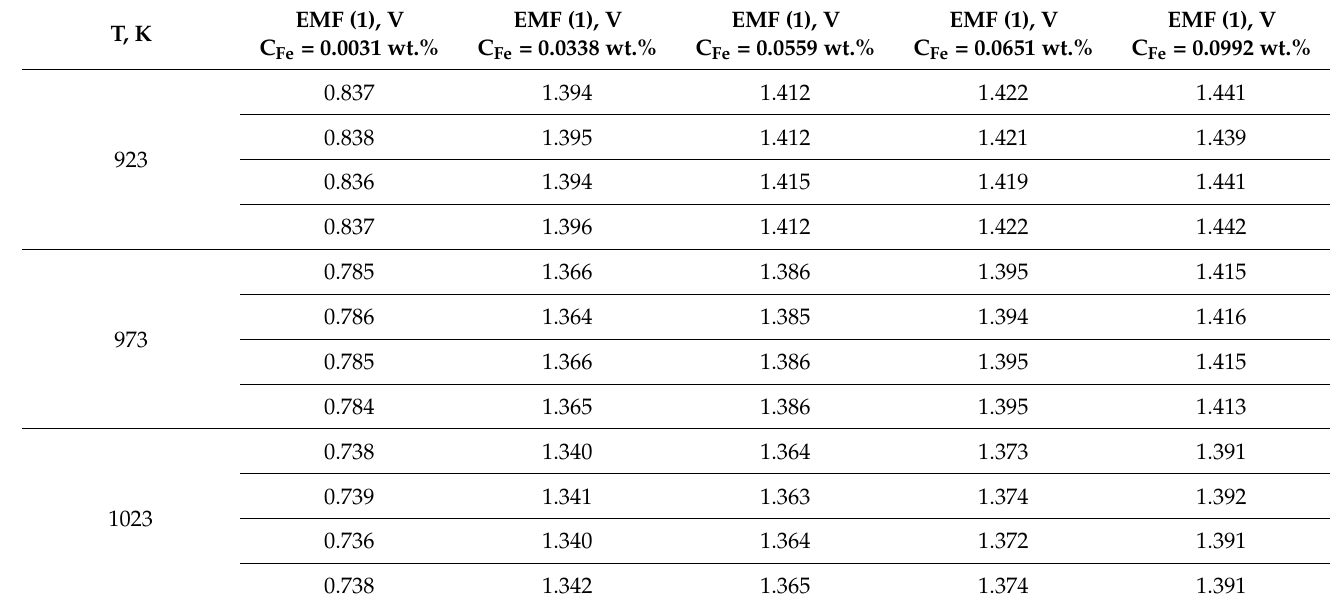
Table 2. Equilibrium potentials of the Fe